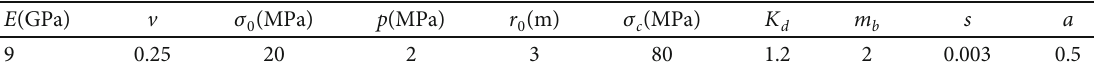
Table 2: The parameters of reference state.